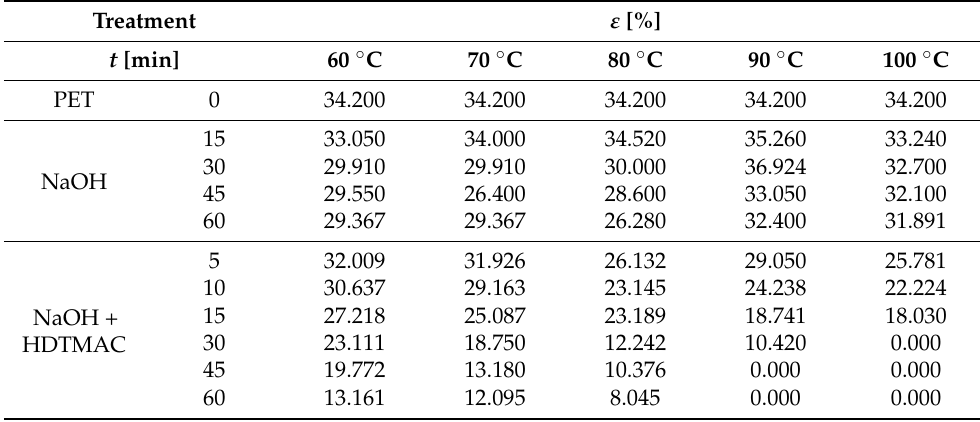
Table 2. Breaking elongation ( ε ) of PET fabrics before and after hydrolysis at 60 to 100 ◦ C.